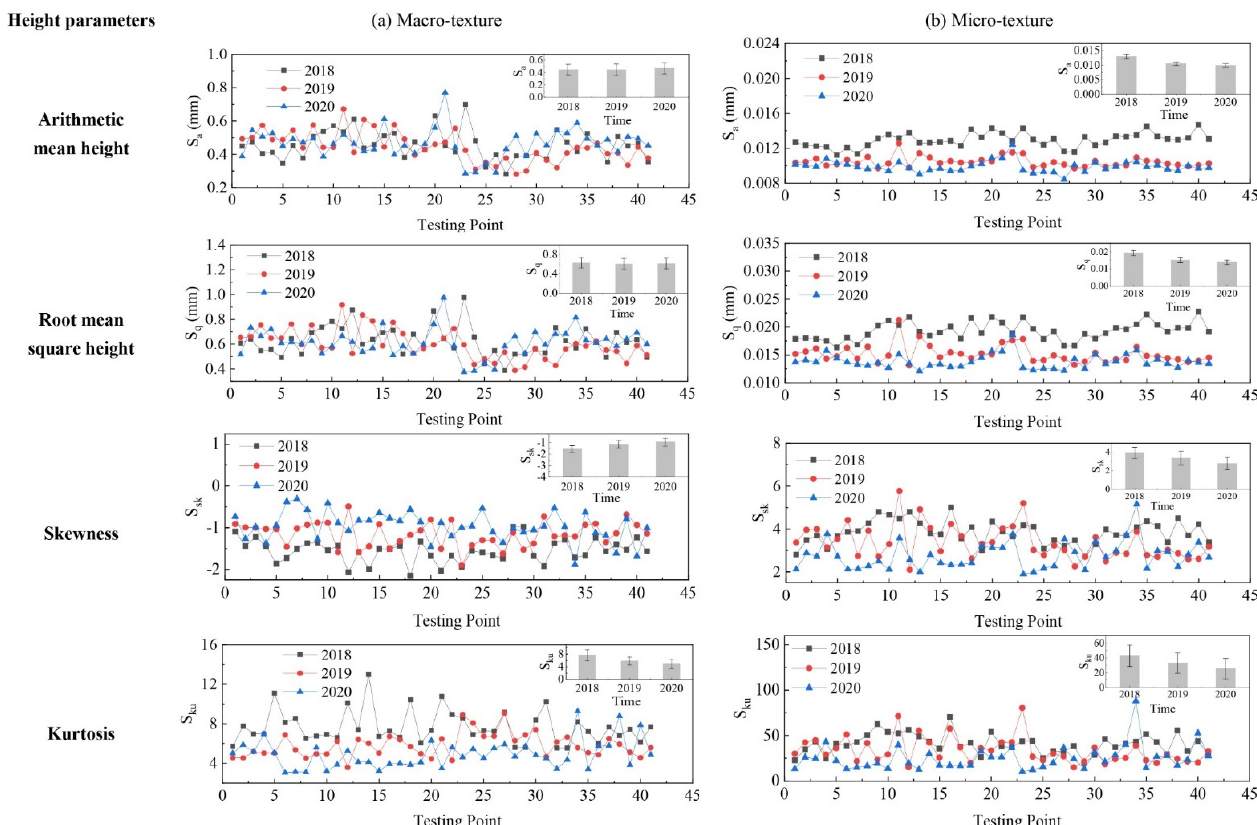
Figure 6. Pavement texture variations via height parameters: ( a ) Macro − texture, and ( b ) Micro − texture.